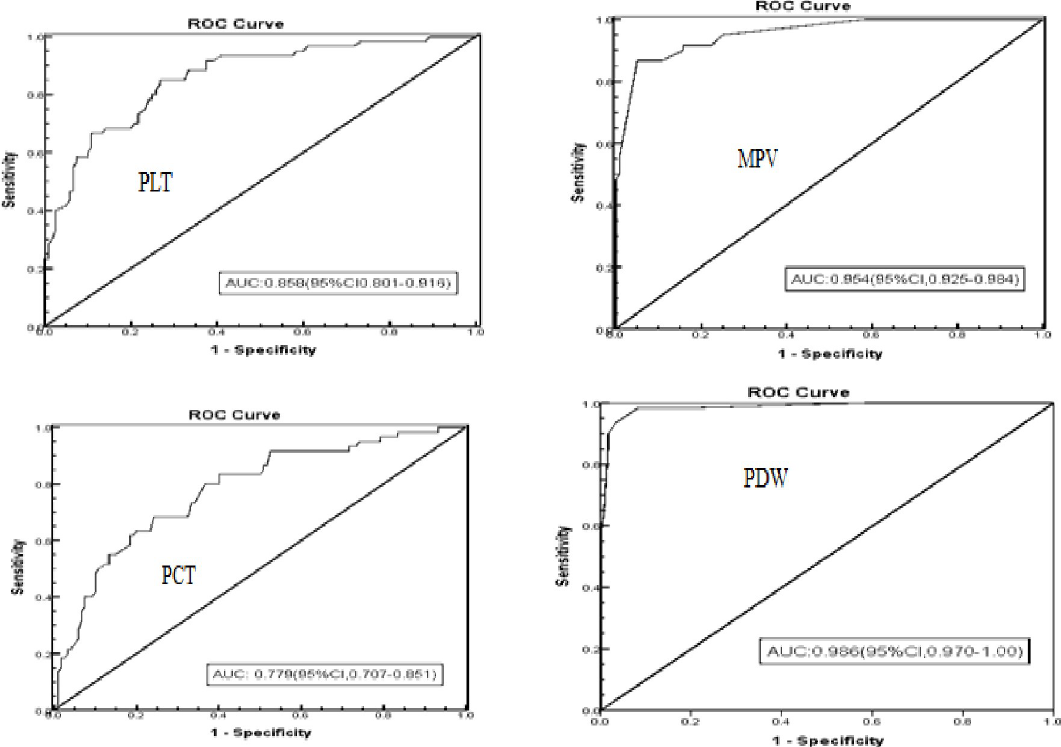
Fig 2. The ROC curve analysis of PLT indices for study participants in NEMMCSH from January 1 to April 3, 2019.